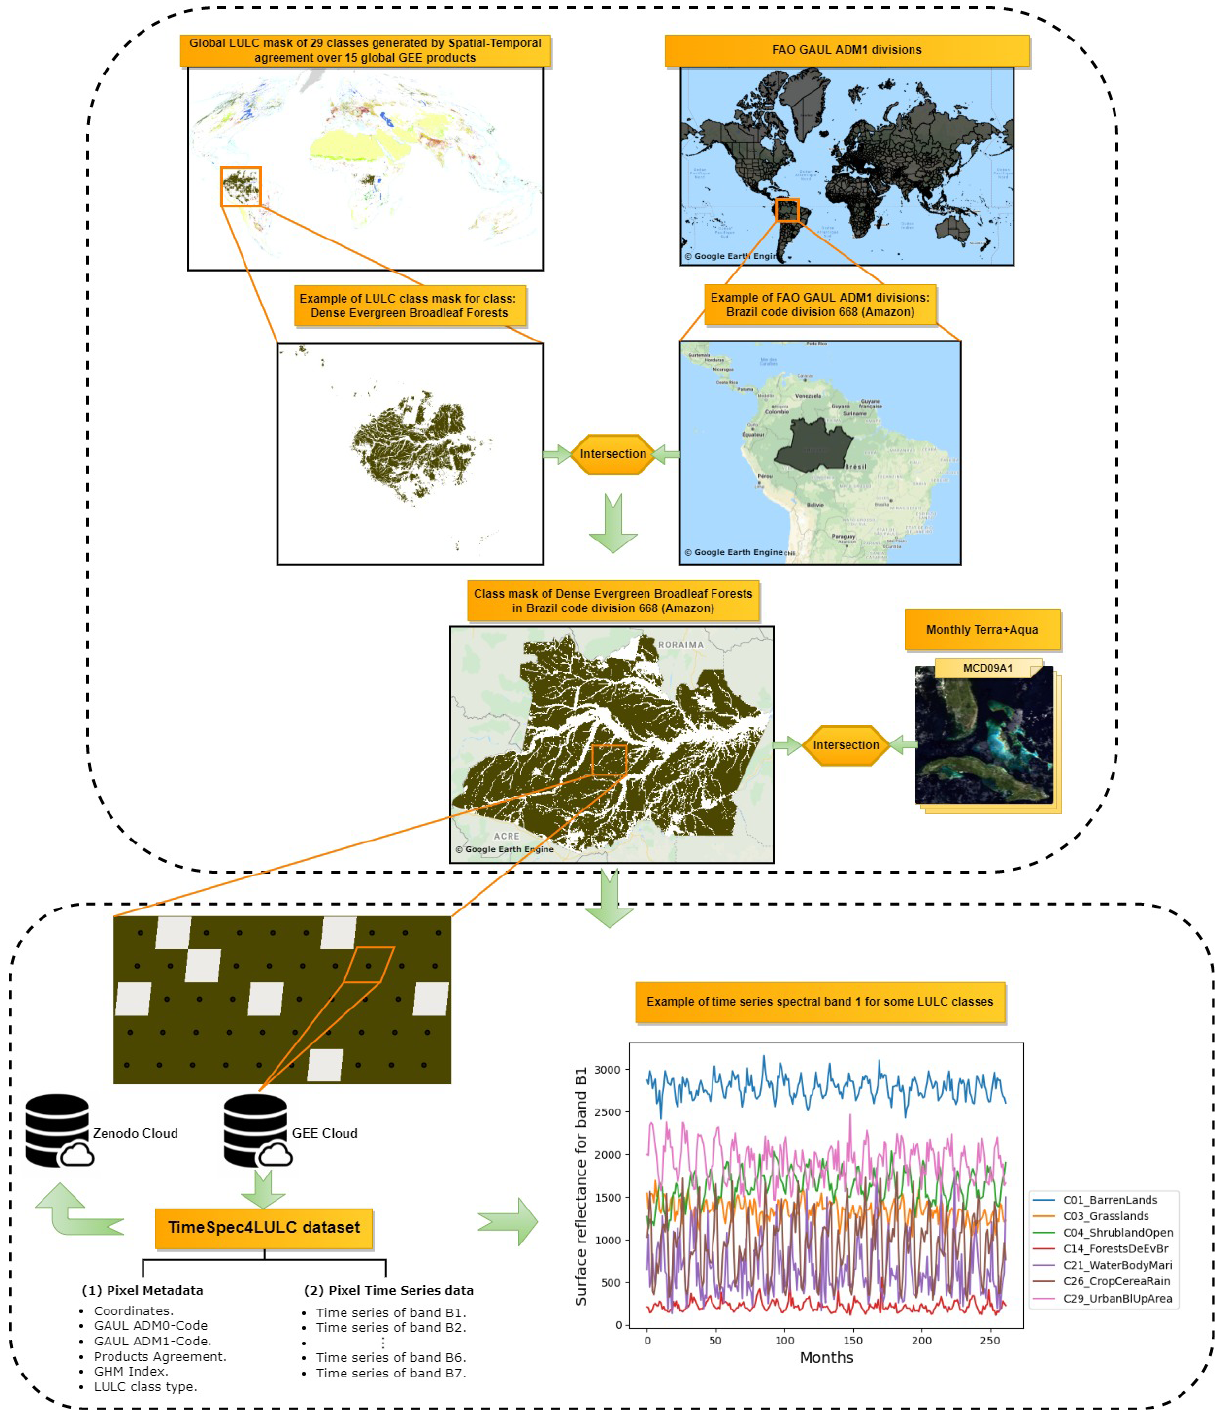
Figure 6. Description of the data extraction process for the LULC class dense evergreen broadleaf forests from all the world’s partitions (GAUL-ADM0, https://developers.google.com/earth-engine/datasets/catalog/FAO_GAUL_2015_level0, last access: 22 March 2022; and GAUL-ADM1, https://developers.google.com/earth-engine/datasets/catalog/FAO_GAUL_2015_level1, last access: 22 March 2022) where this class is available, in addition to a visualization of the first spectral band time series for some LULC classes.